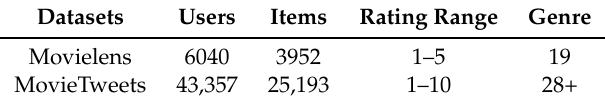
Table 5. Important statistics of datasets used for the